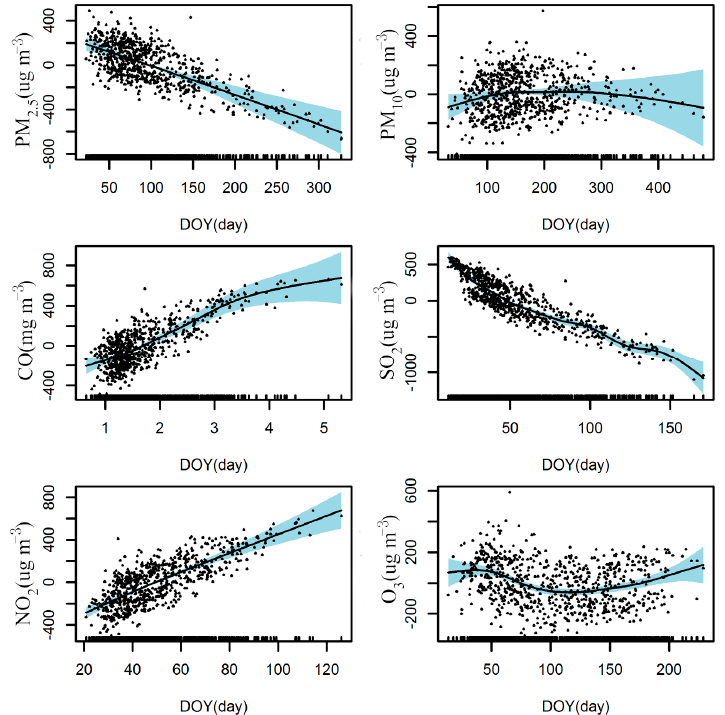
Figure 9. Predicted changes in the principal air pollutants together with temporal dynamics by generalized additive model (GAM) analysis. Rugplot on the x-axis represents the DOY (day of year), and the light blue belts indicate the credible intervals.